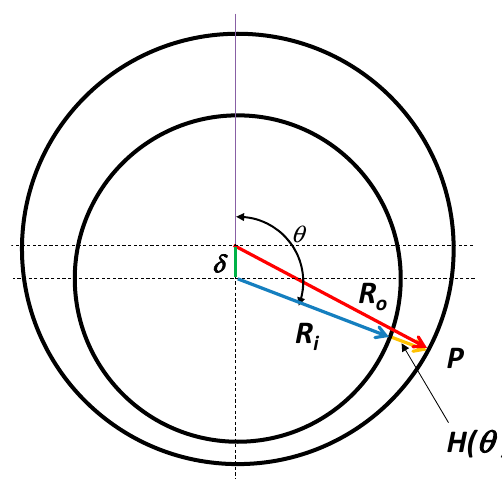
Figure 13. Definition of azimuthal angle θ and angle-dependent gap H( θ ) for eccentric annulus.